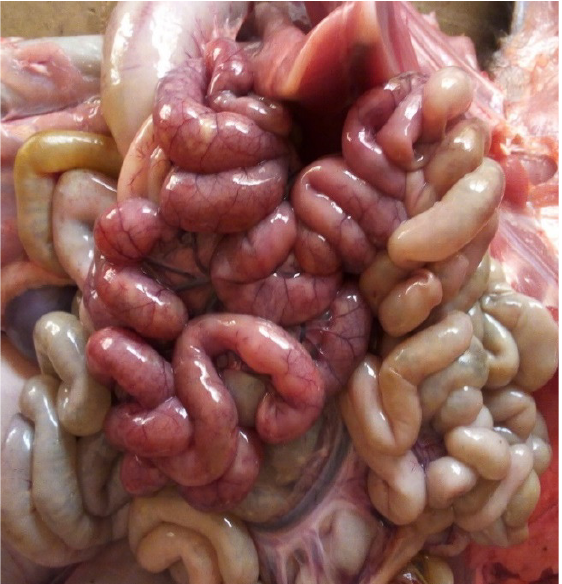
Fig. 5. The small intestines showing severe hyperemia of the serosal surfaces